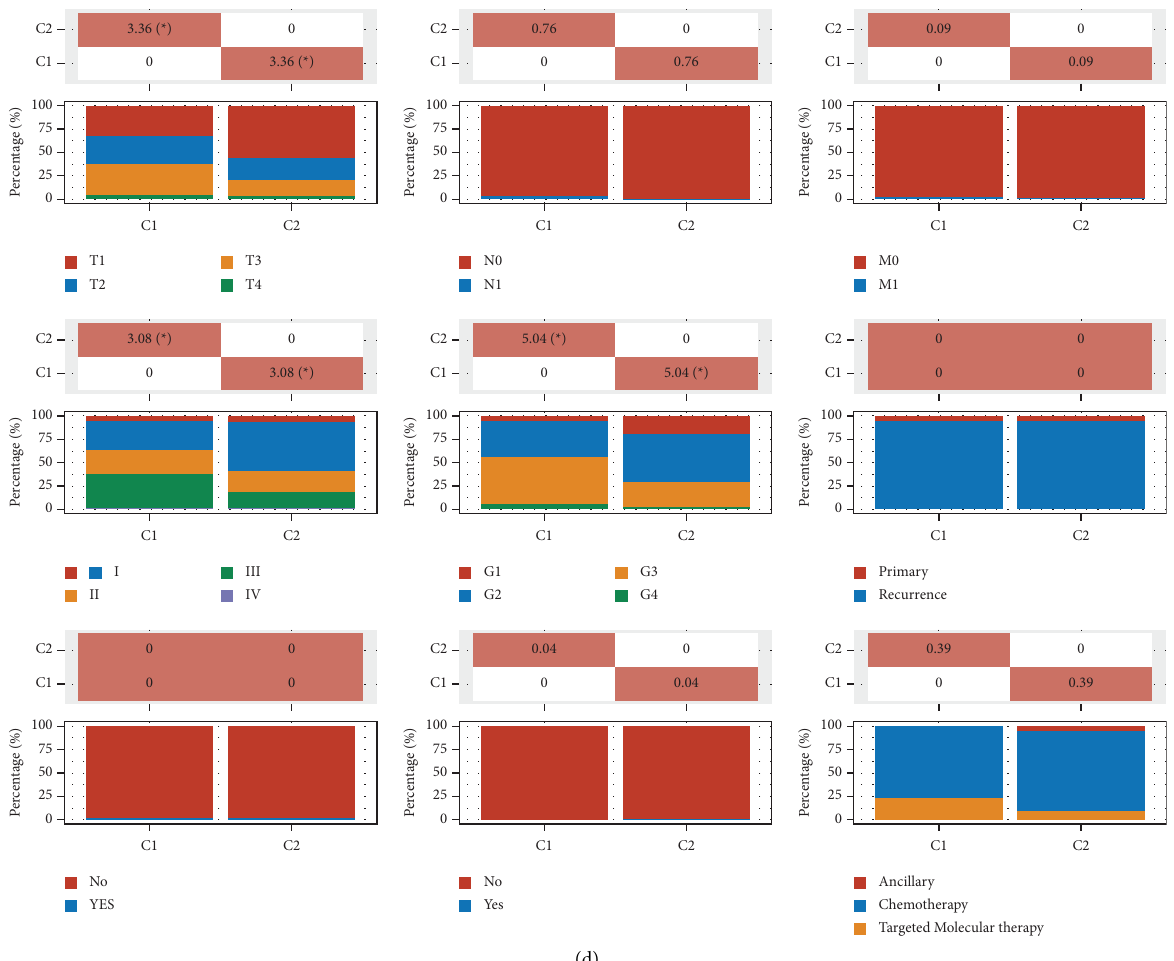
Figure 4: (a) We plotted partial likelihood deviations against log ( λ ) using a LASSO Cox regression model. (b) Based on log rank, the survival curve distribution of the risk model is tested for diferent groups. Te risk model ROC curve and AUC values at diferent times, the higher the AUC value, the more accurate the model. (c) Spearman’s correlation analysis between model scores and immune cell scores. (d) Te correlation analysis between model scores and clinical